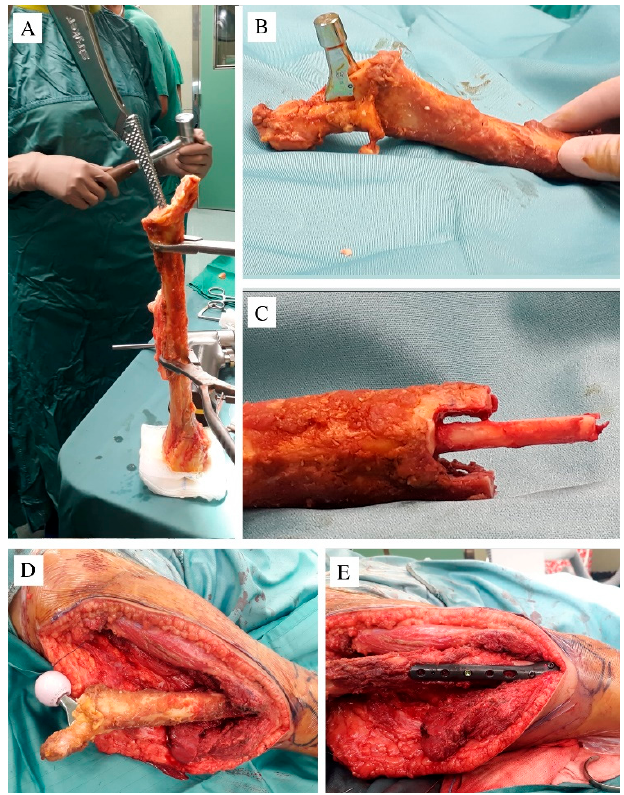
Figure 2. ( A ) The distal humerus after cutting of the medial epicondyle; the broaches were used to create a housing for the prosthesis; ( B ) the prosthesis cemented inside the canal; ( C ) the distal allograft was cut to a diapason shape to fit together with the patient’s residual femur; a cortical strut was cemented in the allograft medullary canal to increase the primary stability when inserted in the residual distal femur; ( D ) a ceramic head of 28 mm was applied; ( E ) the carbon fiber plate and screws used to stabilize the contact area between the allograft and the patient’s femur.